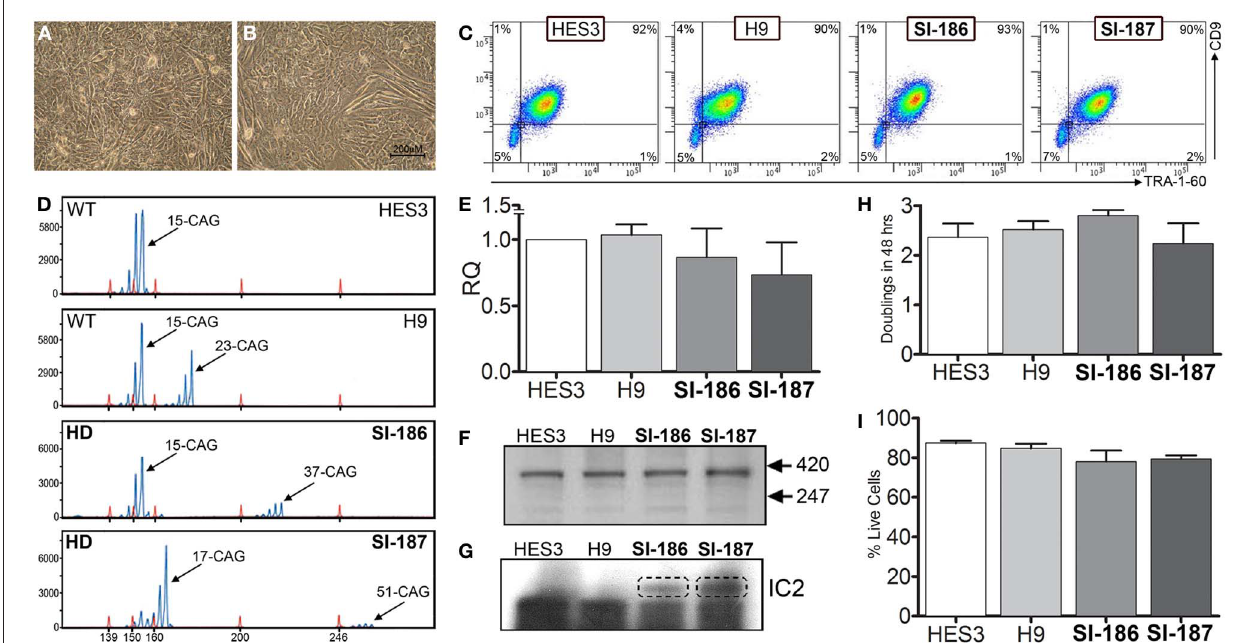
FIGURE 1 | Characterization of pluripotent HD hESC lines demonstrates identical characteristics to control lines. (A,B) Brightfield morphology of hESC bulk cultures. (C) Flow cytometry analysis of hESCs seen as a TRA-1-60 + /CD9 + population; feeder MEFs are a distinct CD9–/TRA-1-60- sub-population. (D) FL-PCR representation of HD genotypes. (E) qRT-PCR of